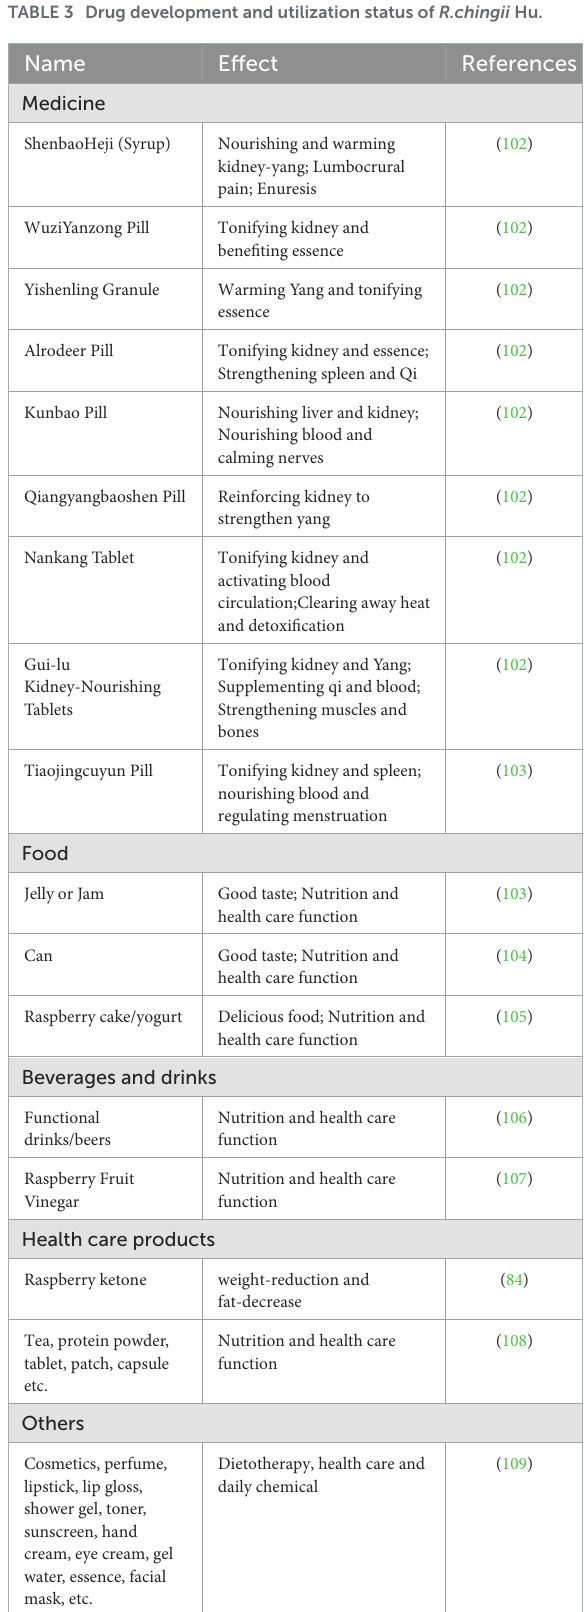
TABLE 3 Drug development and utilization status of R.chingii